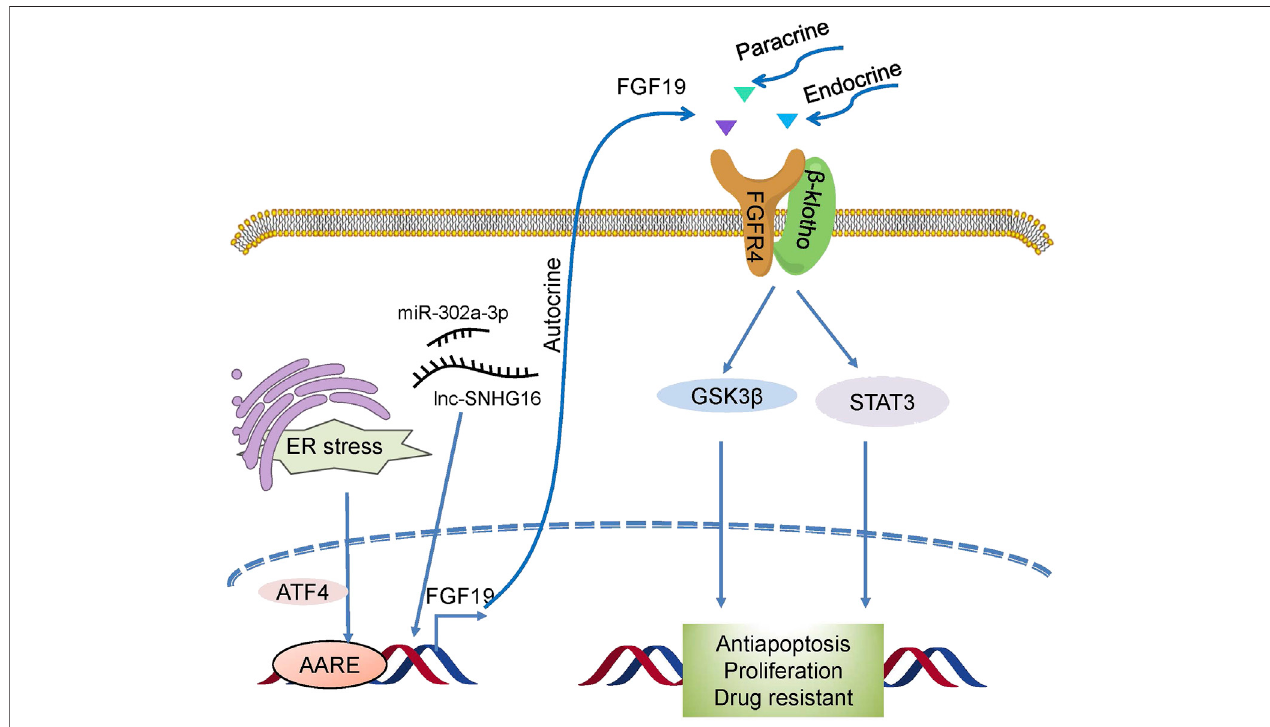
FIGURE5| DrugresistancemechanisminducedbyFGF19/FGFR4.NovelactivatorsactonFGF19/FGFR4,whichthenactivatesGSK3 β / β -cateninwiththeSTAT3 pathway and confers drug resistance to cells.